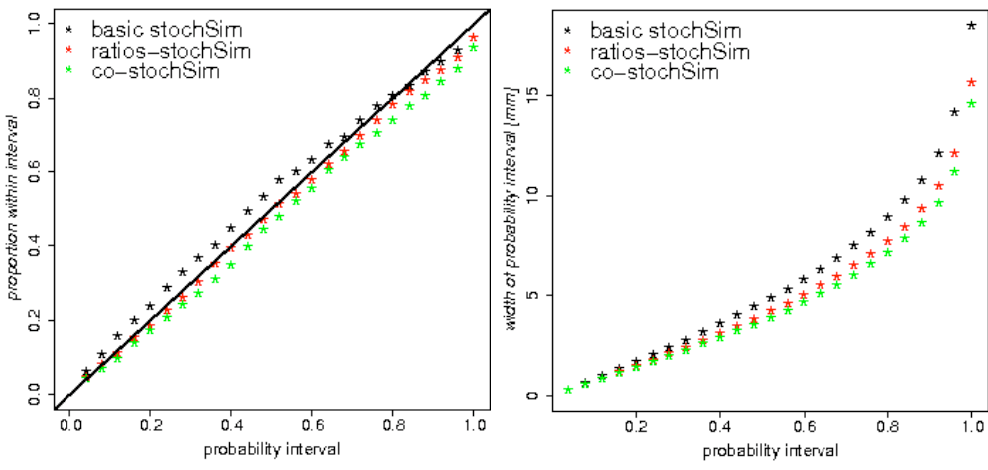
Figure 6. Accuracy plot indicating the ability of the di ff erent interpolators (OK, OCK, KOR) to estimate the true width of uncertainty measure (left), and width of uncertainty measure for PIs (right) for operational rain-gauges in Germany on